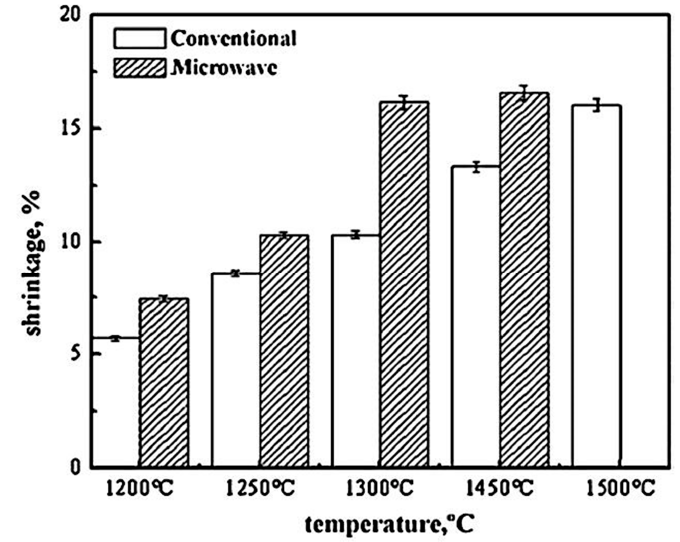
19 of 26 Figure 17. Microcracks at W-W grain boundaries in shear band region [106]. It is projected that the ASB (adiabatic shear bands) will rise in a narrow region when tungsten alloys replace depleted uranium (DU) alloys in defence applications [107]. The ASB is partly maintained by characteristics such as continuity and connection within the tungsten and binder matrix. The compact may be distorted if the liquid phase has volume fractions more significant than 35%. An increase in density of more than 9 g/cc may cause the compact to shape deform. As a result, the alloy retains a 20% liquid volume [108]. The 80W–14Ni–6Fe alloy was shown to have a distortion in its behaviour by German et al. A relative density of 74% was achieved when the compact was sintering at 1475 °C. It sug- gests that solid phase sintering has a low densification rate. When temperatures rise above 1475 °C, the liquid phase begins. As a result, there were no substantial changes in densi- ties. However, sintering at 1500 °C resulted in practically complete densification. At this temperature, the sintering time was increased to 30 min to observe how distortion occurs.